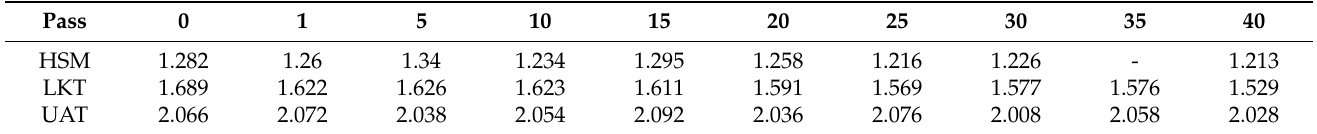
Table 9. Calculated volumes (m 3 ) for individual plots and various passes of machines.